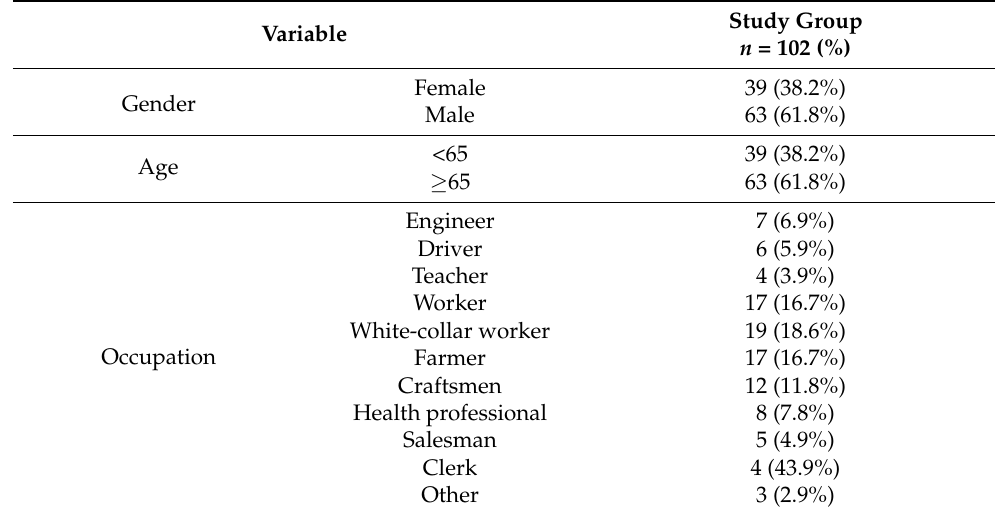
Table 1. Characteristics of the study group.